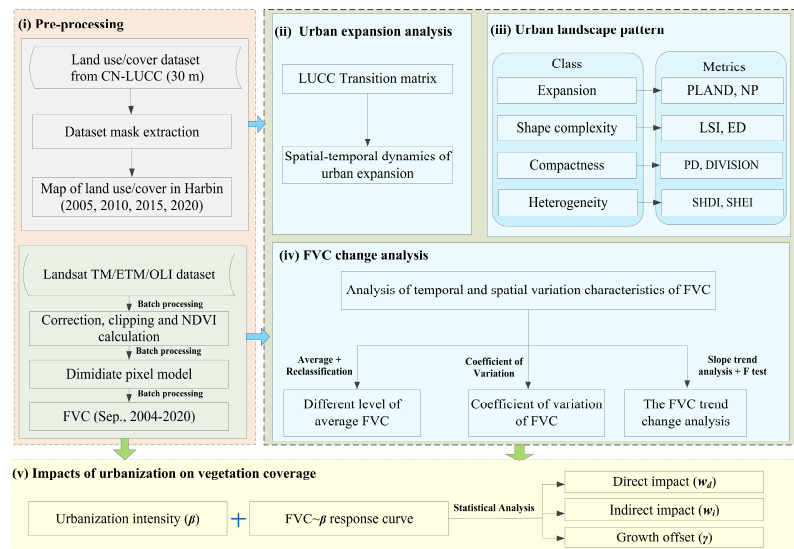
Figure 3. Flowchart of the